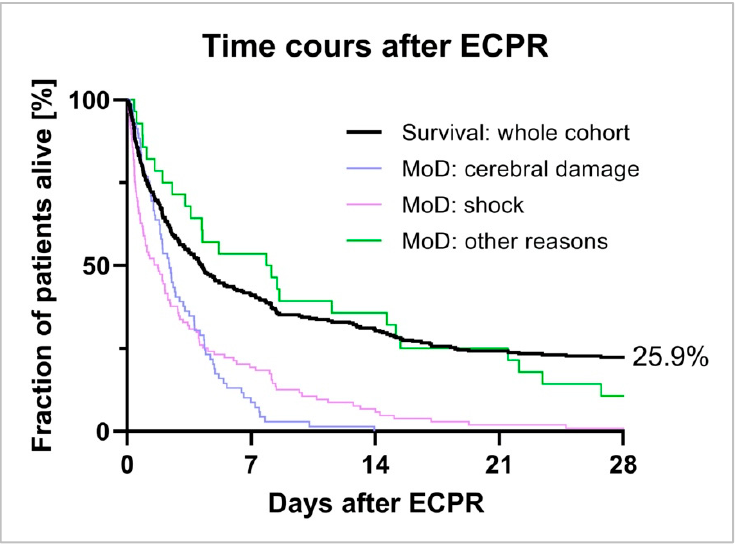
Figure 3. Time course after ECPR. Death after ECPR in the whole cohort and in selected subgroups.